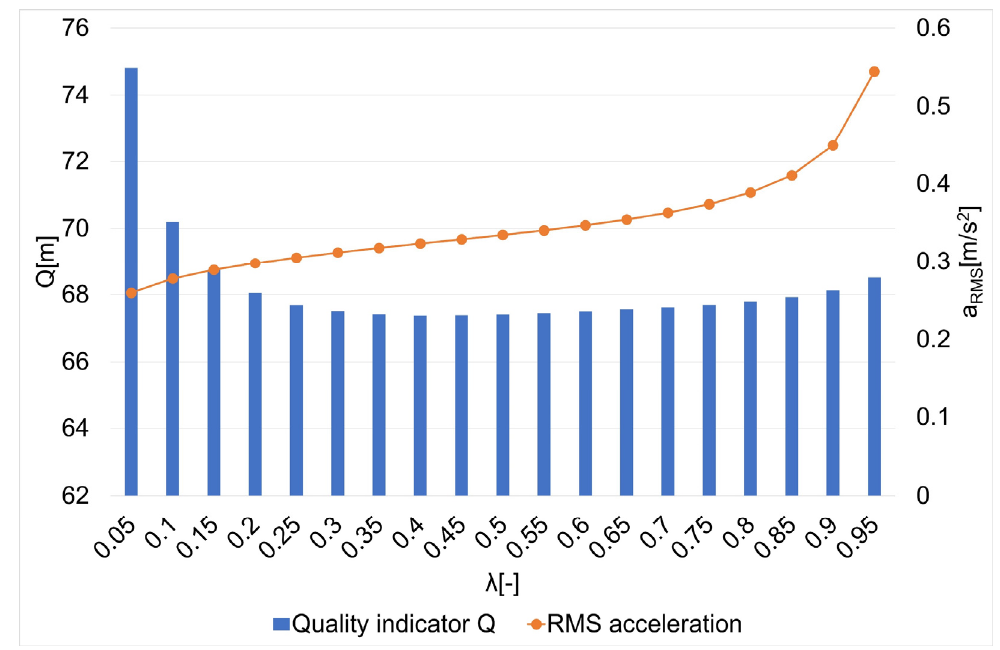
Figure 5. The values of the quality indicator Q and the mean square value of acceleration a RMS for the smoothing parameters in the case of path no. 1 [6].